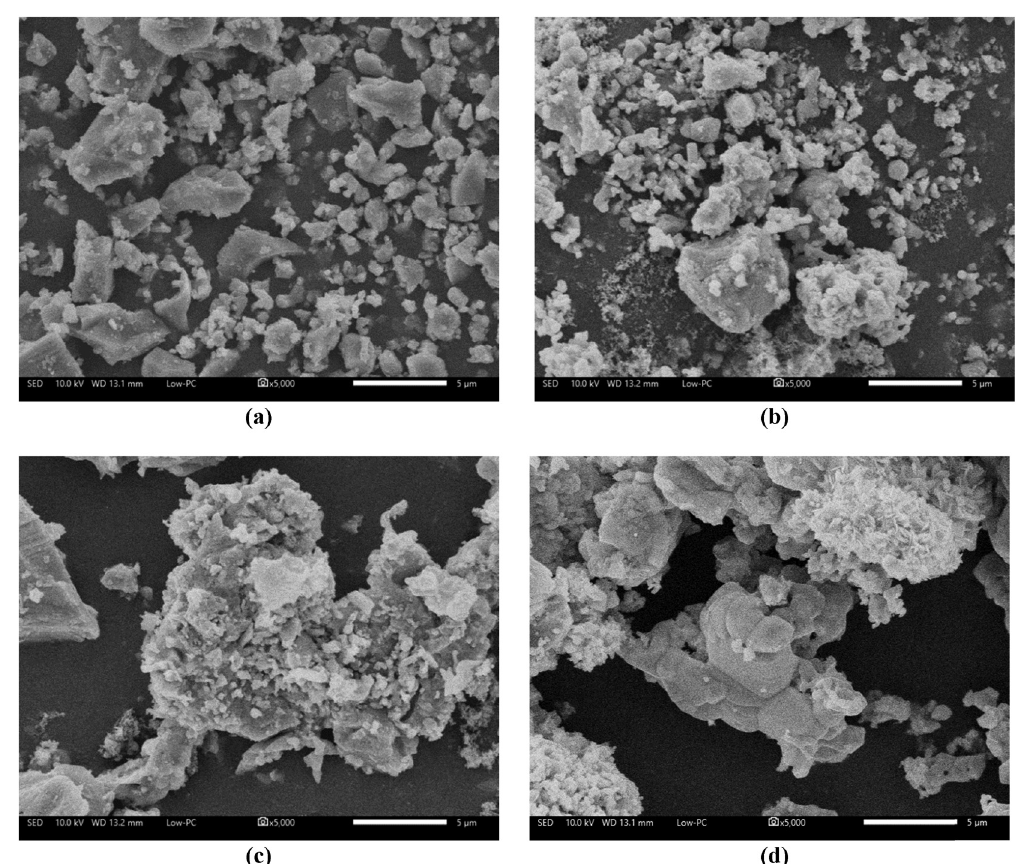
Figure 7: SEM images of LiFePO 4 /C sample with carbon additions of ( a ) 0%, ( b ) 7%, ( c ) 10% and ( d )